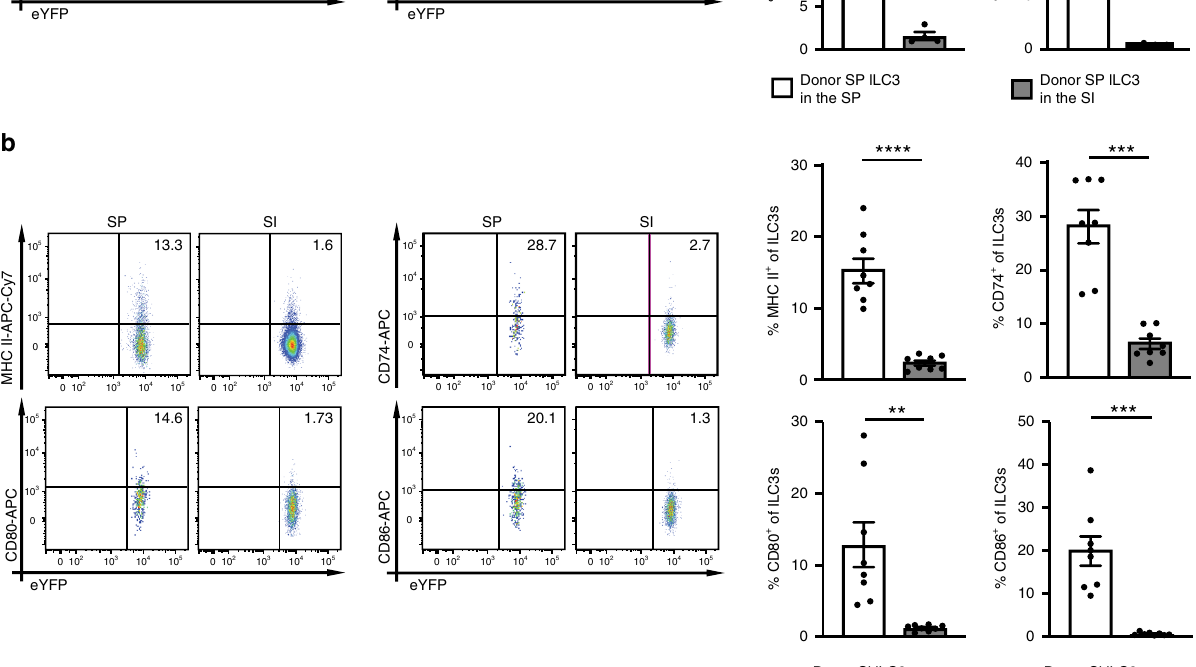
Importantly, SP donor ILC3s isolated from the SI of recipients had down-modulated CD80, CD86, CD74, and MHC II (Fig. 3a). Conversely, SI donor ILC3s isolated from the SP of recipients had upregulated these molecules (Fig. 3b). Similar results were obtained 7 days after adoptive transfer of total splenocytes or intestinal lymphocytes into Rag2 − / − Il2rg − / − mice